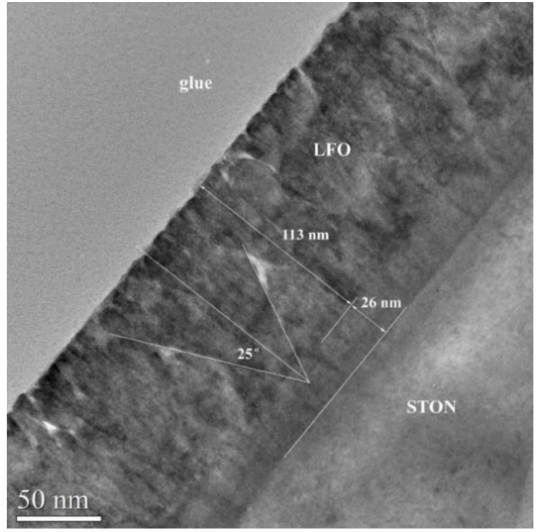
Figure 9. Low-magnification XTEM image of the LFO/STON film with the thickness of about 132 nm.